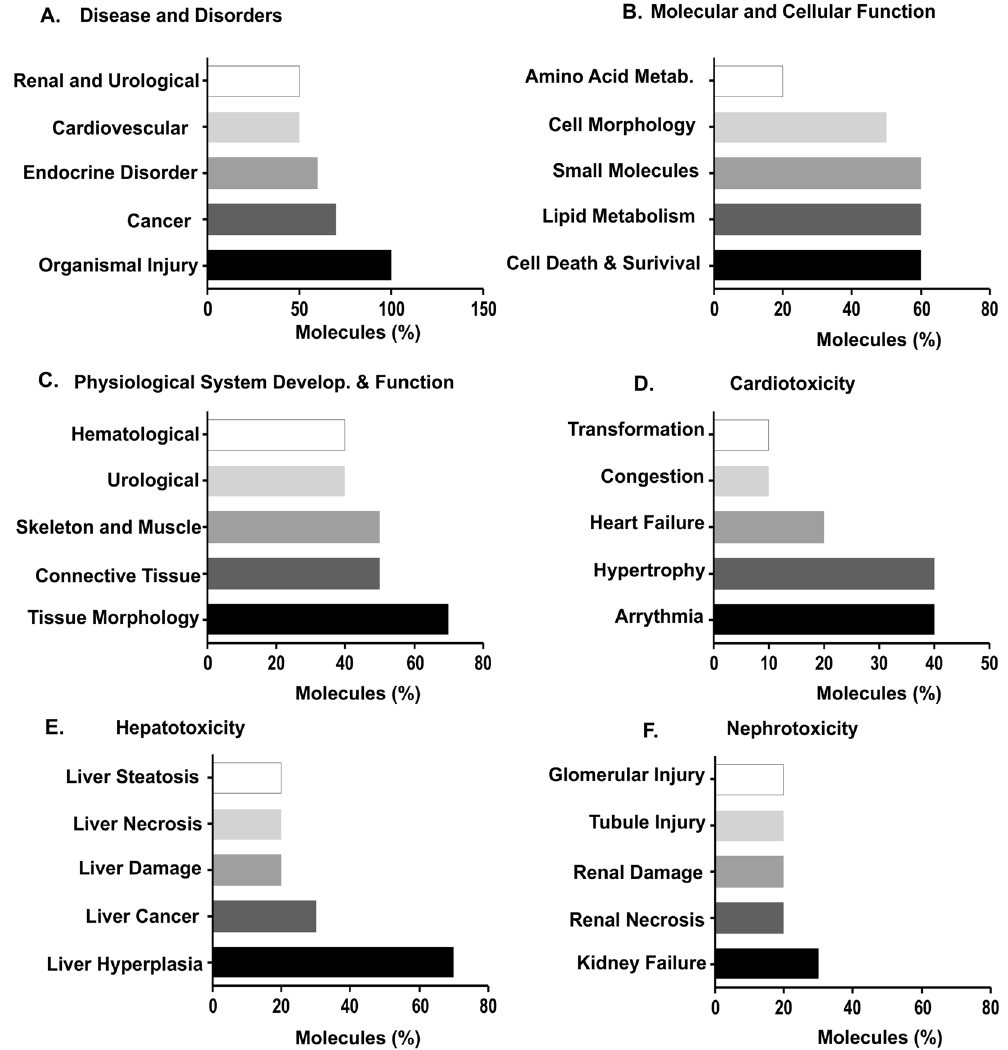
Figure 4. Top functions of over expressed genes in STZ treated T1D mice with cardiac dysfunction. ( A ) Top disease and disorders, ( B ) Top molecular and cellular function, ( C ) Top physiological system and development and function, ( D–F ) Organ-specific top toxicology function. The X axis represents the percentage of molecules among 10 differentially expressed genes involved in different